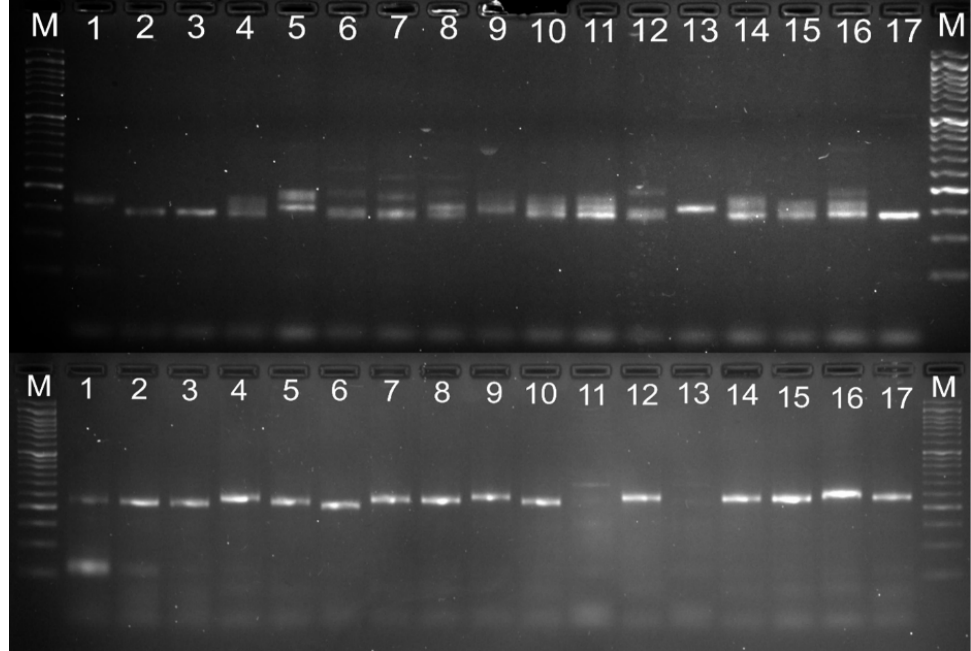
Figure 2. PCR amplification products of wheat genotypes with xbarc321 and xbarc57 markers linked to Lr63 locus. M- 50 bp DNA Ladder (NIPPON Genetics EUROPE GmbH); 1 –17—wheat genotypes.